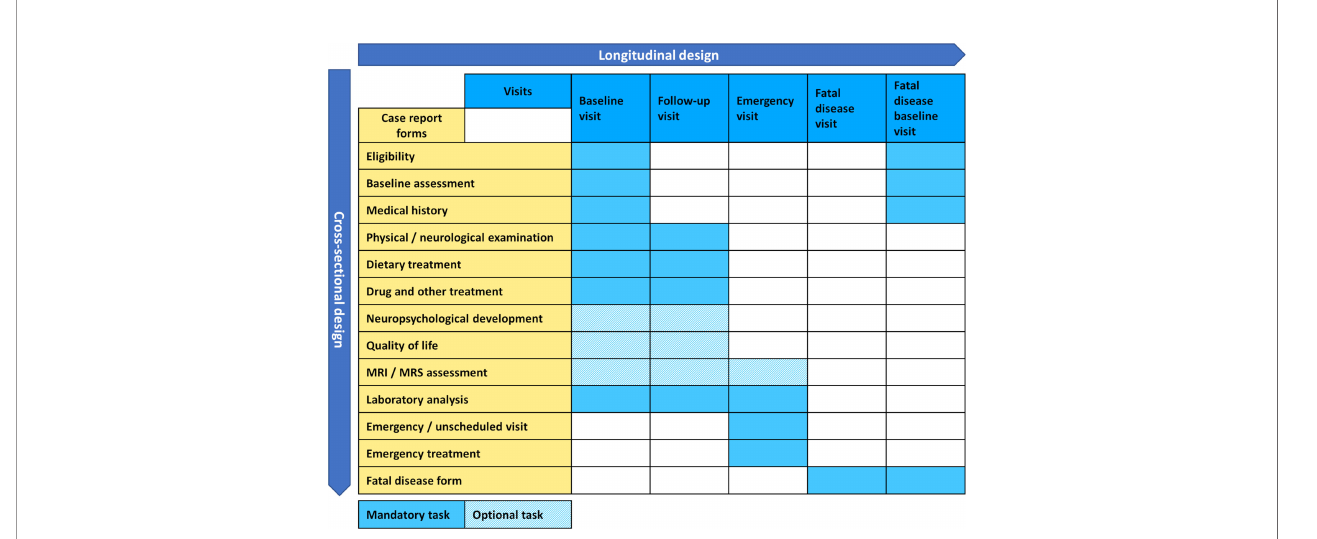
FIGURE 1 | General design of the E-IMD, E-HOD, iNTD and U-IMD